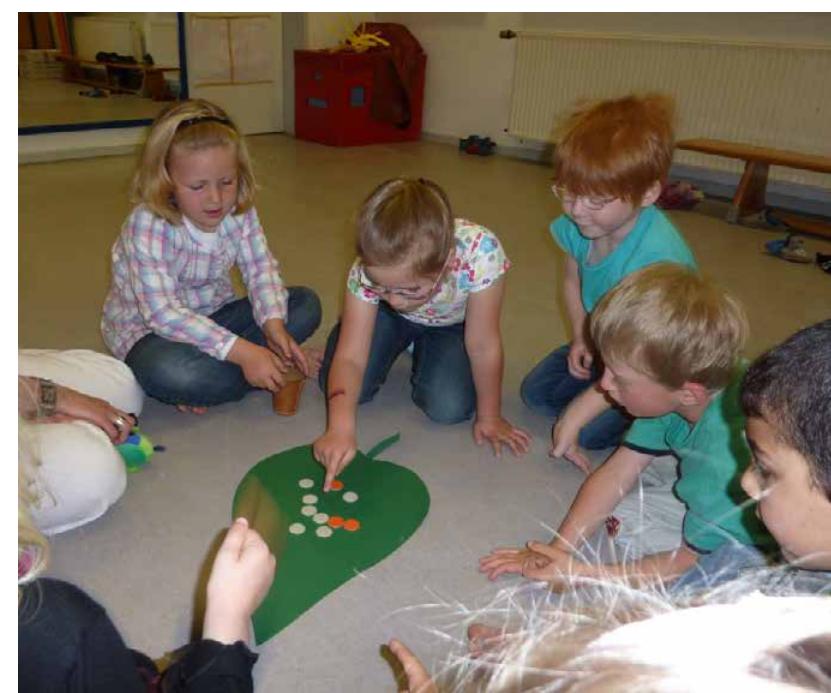
Figure 5: Children are practicing counting in a game: the chips are thrown – ‘ How many white chips are there? How many red chips are there